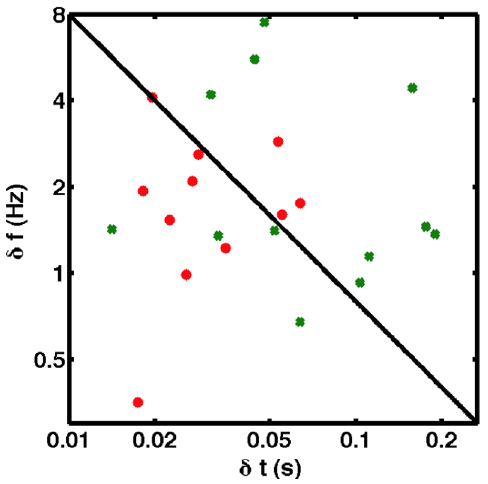
Figure 2. Results of Psychophysical Testing. We plot our data on a standard time-frequency plane with d t on the x axis and d f on the y axis. The red circles are the results from the ‘‘time-forward’’ notelike pulse, the green crosses are from the ‘‘time-reversed’’ version. The uncertainty bound is the black diagonal; the axes are logarithmic. The data from the ‘‘time-reversed’’ pulse are shifted notably to the right ( z d t ) from the original ‘‘time-forward’’ notelike one.